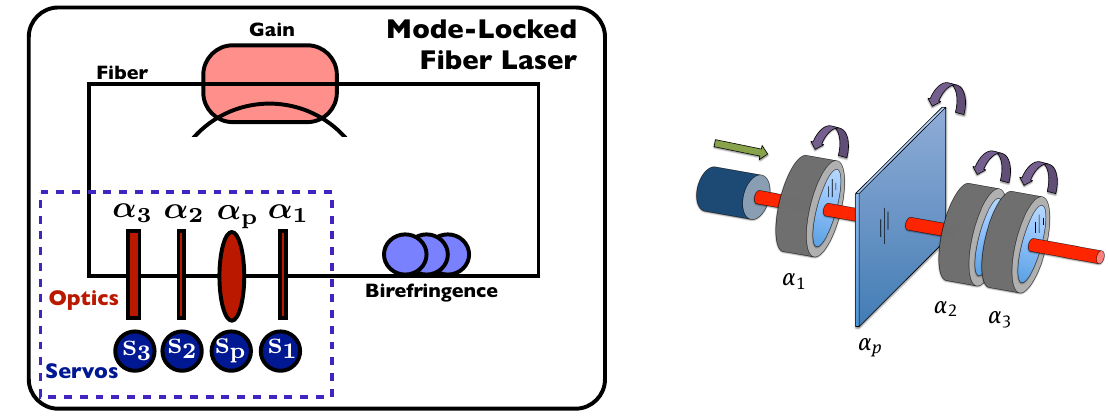
Figure 1: Experimental configuration of a ring laser cavity that includes quarter-waveplates (QWP), passive polarizer, half-waveplate (HWP), ytterbium-doped (or Erbium-doped) amplification and output coupler. The Yb-doped section of fiber is fused with standard single-mode fiber and treated in a distributed fashion. The angles of the waveplates and polarizer are denoted by α j with j = 1, 2, 3, p . Each of these is on a servo-driven motor denoted by S j . The right panel shows the physical configuration for tuning the laser. The fiber birefringence is modified through mechanical disturbances (bending) and/or environmental fluctuations in temperature, thus greatly compromising mode- locking performance and frequency comb